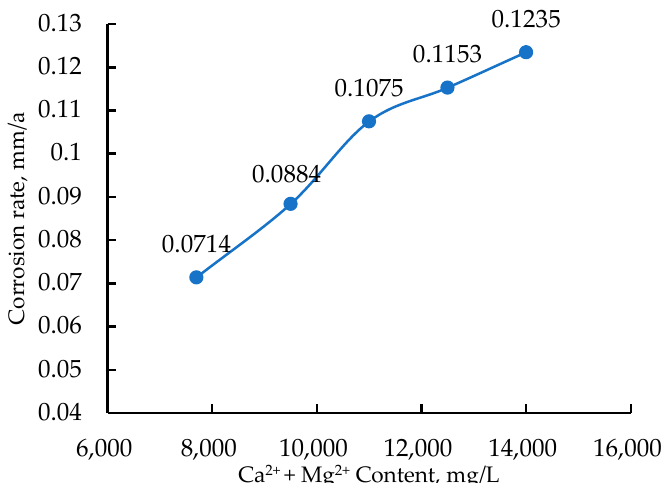
Figure 7. Variation curve of dynamic corrosion rate of 20# steel with Ca 2 + + Mg 2 + content. The corrosion morphology under different Ca 2+ +Mg 2+ content is shown in Figure 8.